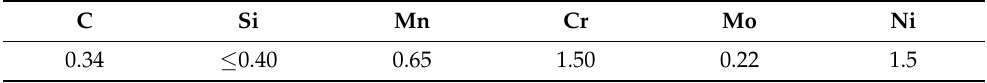
Table 1. Nominal chemical composition (wt.%) of 34CrNiMo6 high-strength steel [44].